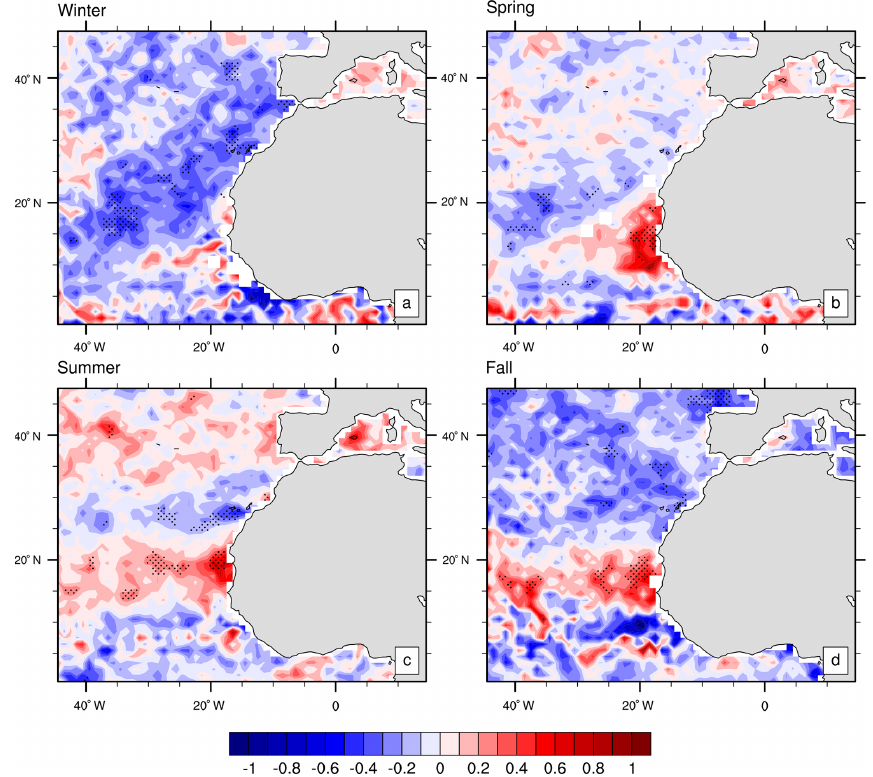
Figure 12. The sensitivity of liquid water path to a relative change in aerosol index for (a) winter, (b) spring, (c) summer, and (d) fall. Dots represent the significance at the 95% confidence